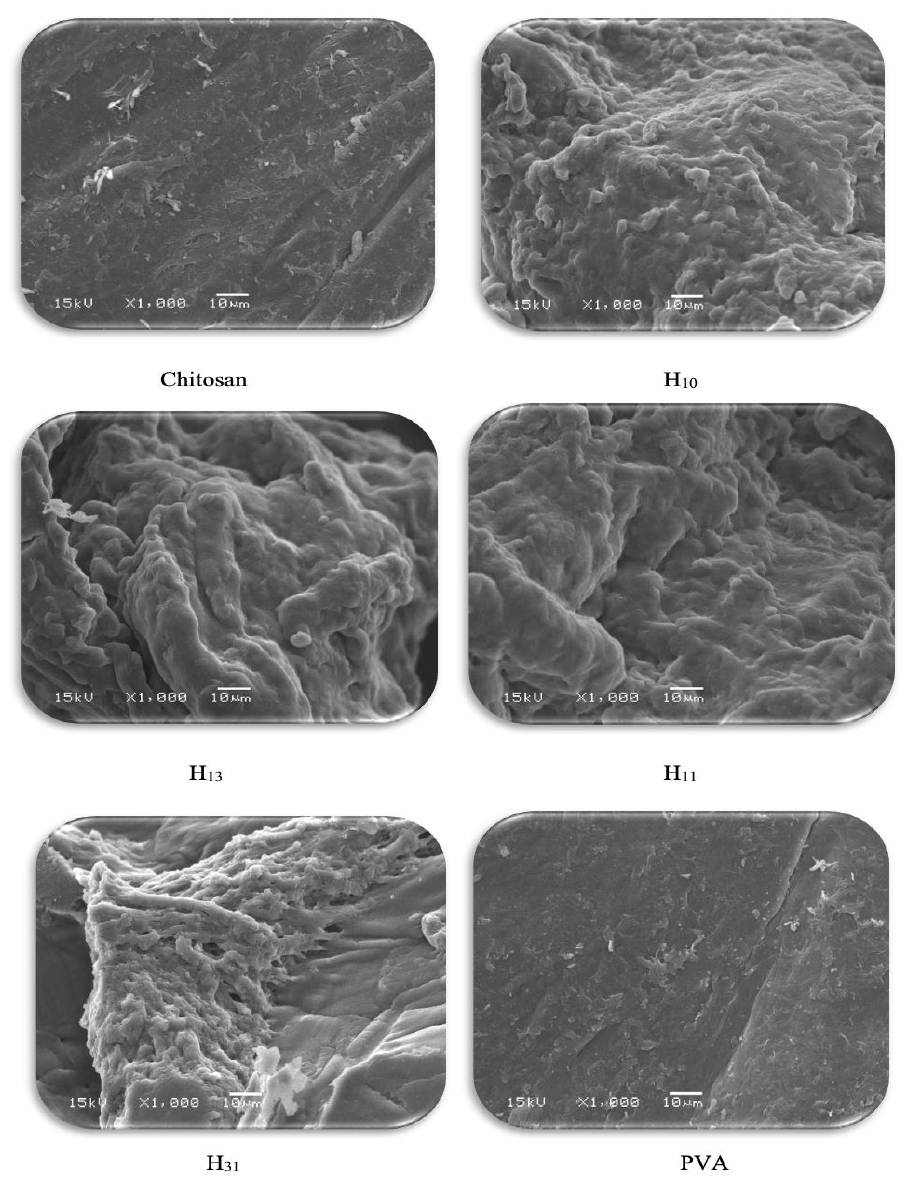
Figure 6. SEM images of chitosan, H 10 , PVA , H 13 , H 11 and H 31 .